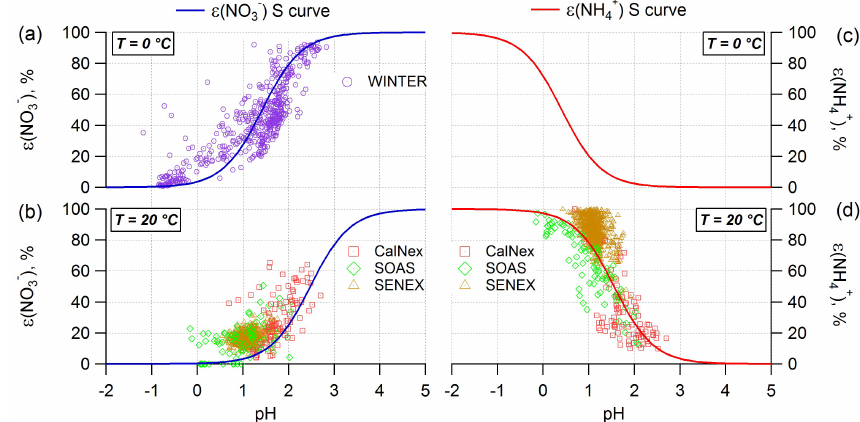
) and ε (NH + ) and ambient data, plotted with ISORROPIA-predicted pH for CalNex, Figure 8. Analytically calculated S curves of ε (NO − 3 4 ) and ε (NH + ) are the fraction of the total (gas + particle) in the particle phase. For the SOAS, SENEX, and WINTER studies. ε (NO − 3 4 data, a narrow range in W i (1–4µgm − 3 ) and T ( − 5< T <5 ◦ C for T = 0 ◦ C, 15< T <25 ◦ C for T = 20 ◦ C) data were selected to be close to the analytical calculation input (i.e., W i = 2 . 5µgm − 3 and various T ). For analytical calculations (S curves), γ ISORROPIA-II predicted γ 0 . 23 (WINTER) and 0.28 (CalNex 0.28, SOAS 0.29, SENEX 0.26) were H + − NO − 3